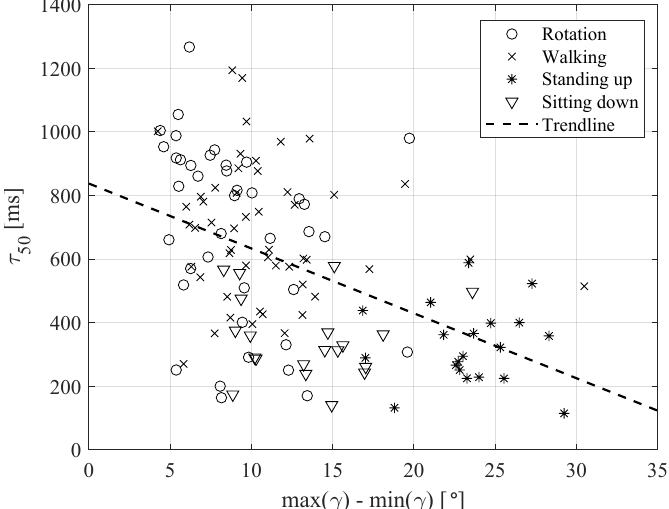
Figure 5. Relation between coherence time and maximum change in local roll angle (metric (a), parameter #2).